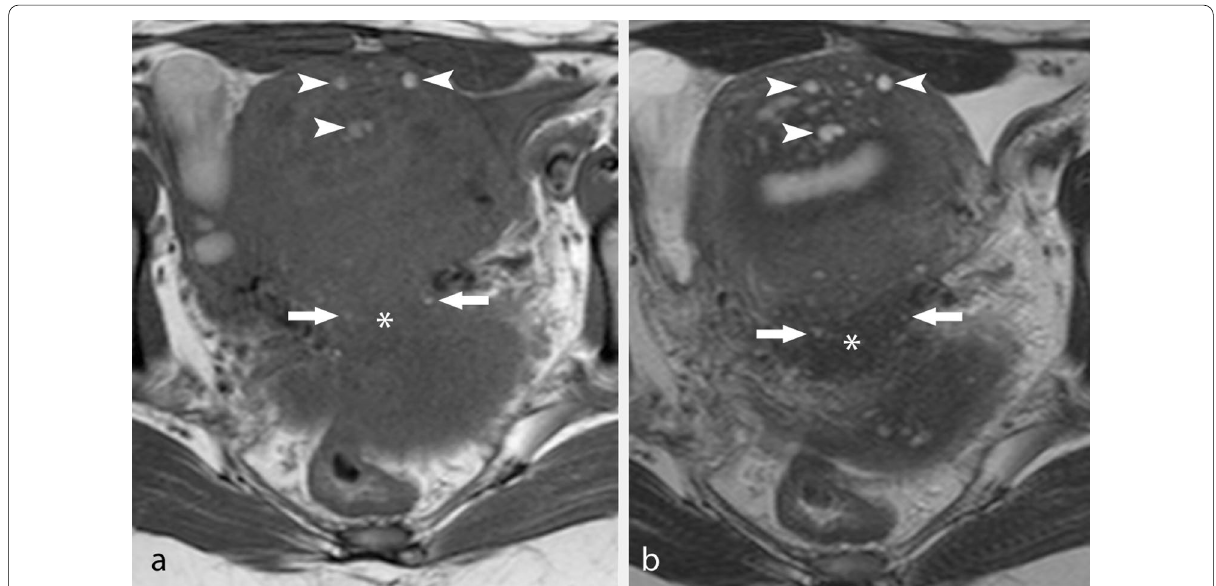
Fig. 6 Retro-uterine DIE nodule. TSE T1w image and TSE T2w image. DIE nodules are characterized by intermediate signal intensity in T1w images (* in a ) and low signal intensity in T2w images (* in b ), with high intensity foci in both sequences (arrows). Adenomyosis is also shown with a similar MR aspect within the anterior wall of the uterus (arrowheads)